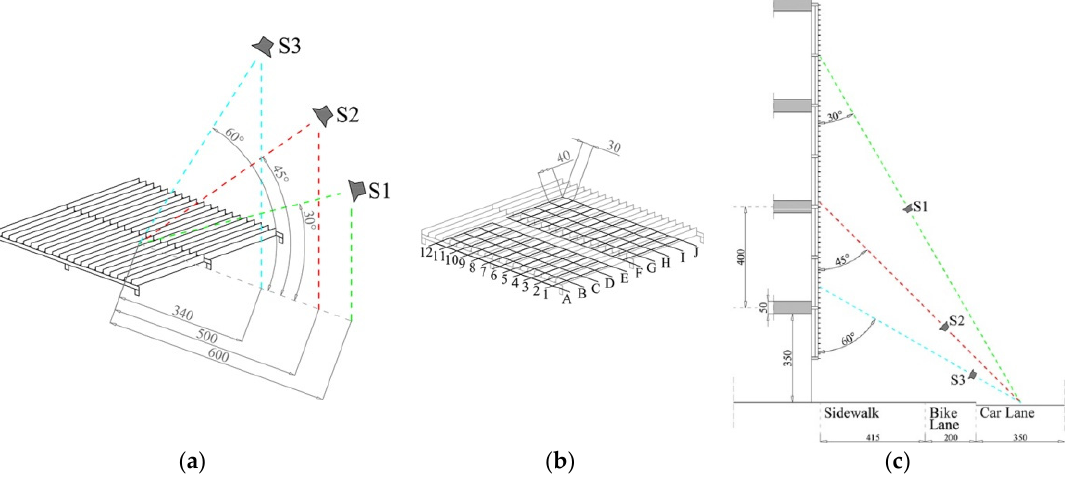
Figure 5. ( a ) The three positions of the sound source with respect to the model; ( b ) the grid of 120 microphone positions used in the measurements; and ( c ) section of a hypothetical building facade and a road. The source positions in the semi ‐ anechoic chamber are shown as a fixed road lane. Dimensions are in cm.